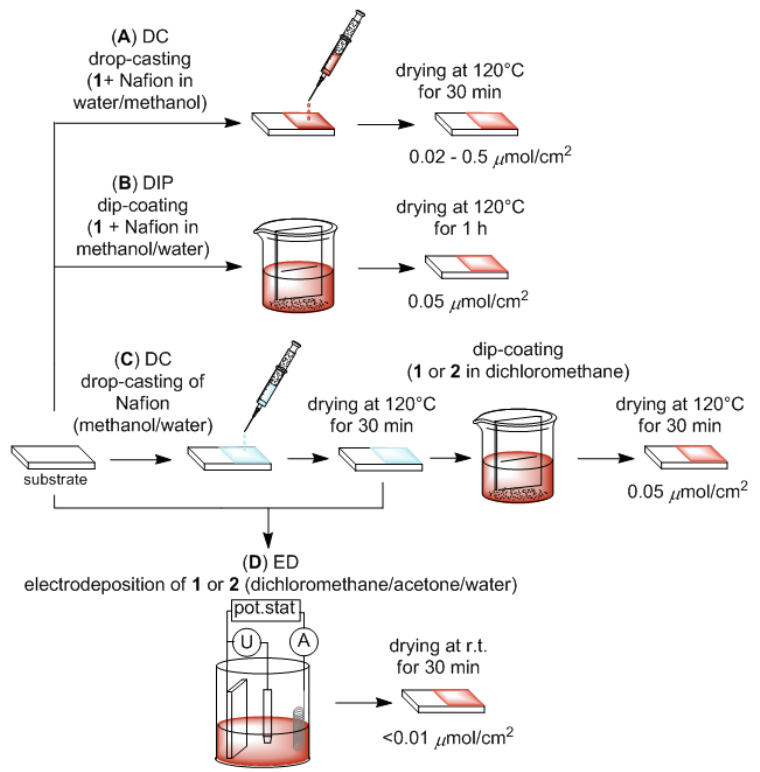
Figure 1. Schematic presentation of the different deposition methods applied in this